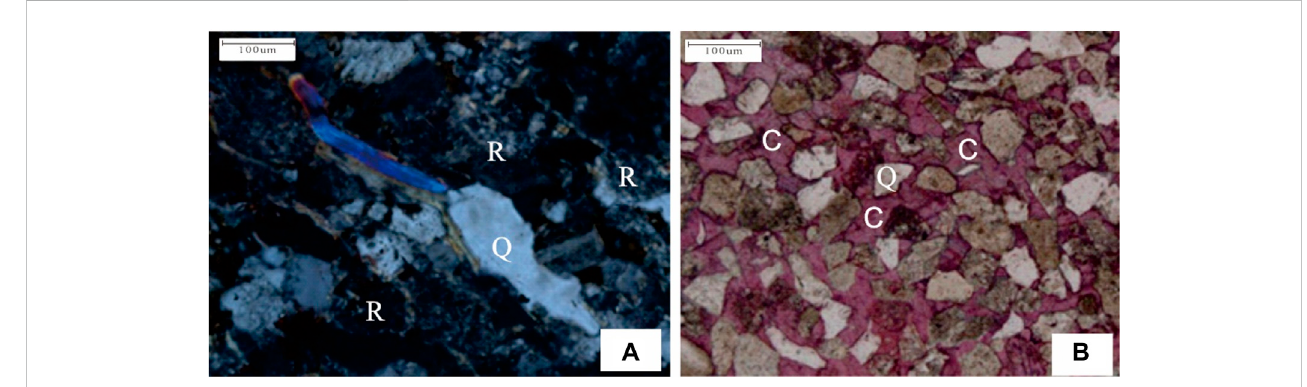
FIGURE 10 PhotomicrographsofthecompactionandcementationintheGaotaizioillayerintheQijiaarea; (A) WellJin341,2076.49 m,compaction; (B) WellQiping 1, 1956.12 m,